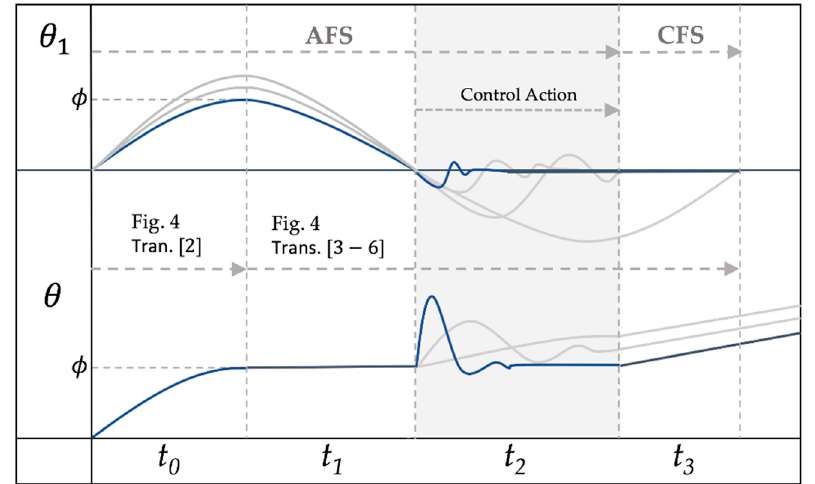
Figure 7. Proposed timeline of slosh induction method (SIM) pouring. AFS ranges from the initial tilting to the end of the control action. CFS initiates at the end of AFS and continues till the end of pouring.